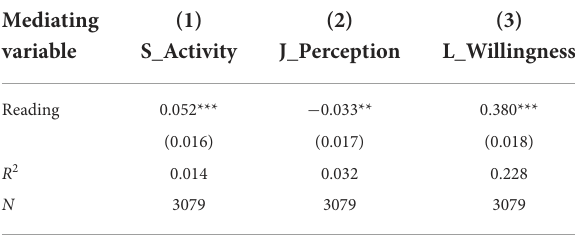
TABLE 5 Regression results of mediated